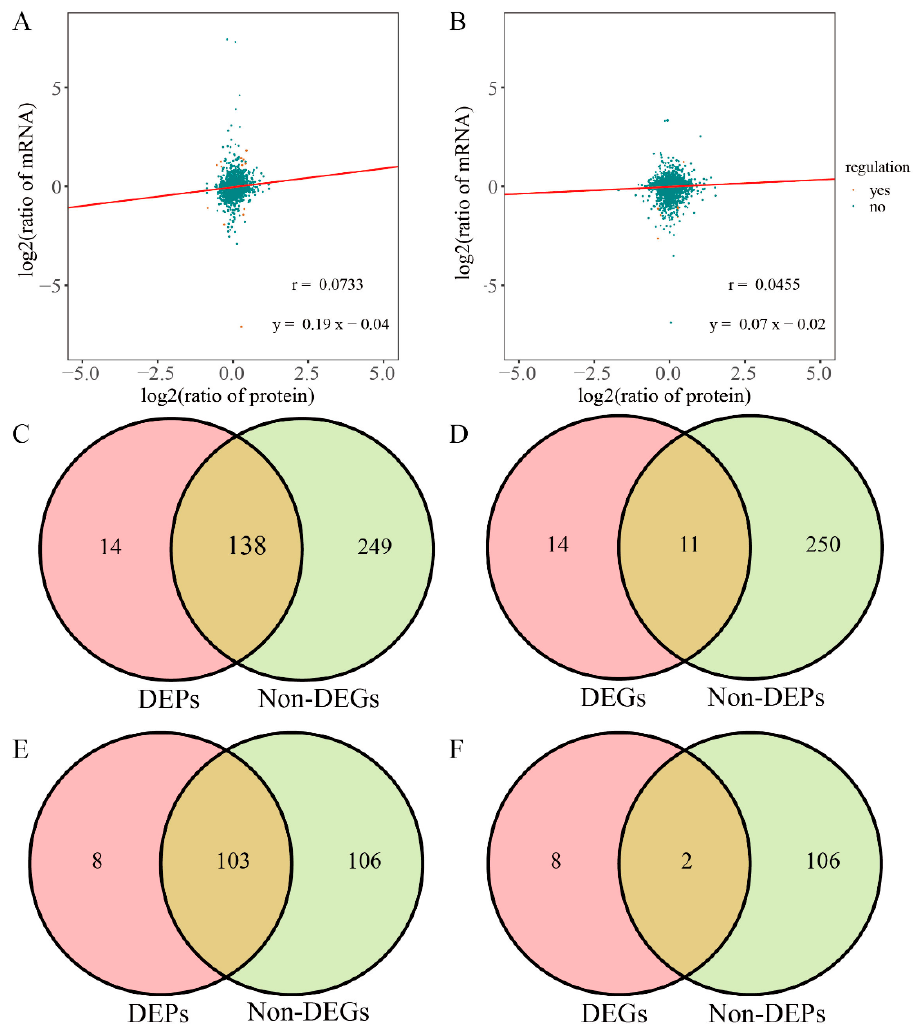
Figure 2. Correlation between DEPS and their corresponding genes and Venn diagram analysis of the associated proteins and genes. ( A ) Association graphs of the DEPs under salt stress related to the corresponding genes in line 8723; ( B ) association graphs of the DEPs under salt stress related to the corresponding genes in P138; ( C , D ) Venn diagram of the associated genes and proteins of line 8723 under salt stress; ( E , F ) Venn diagram of P138-associated genes and proteins in response to salt stress. Abbreviations: DEPs—differentially expressed proteins; DEGs—differentially expressed genes; Non-DEPs—non-differentially expressed proteins; Non-DEGs—non-differentially expressed